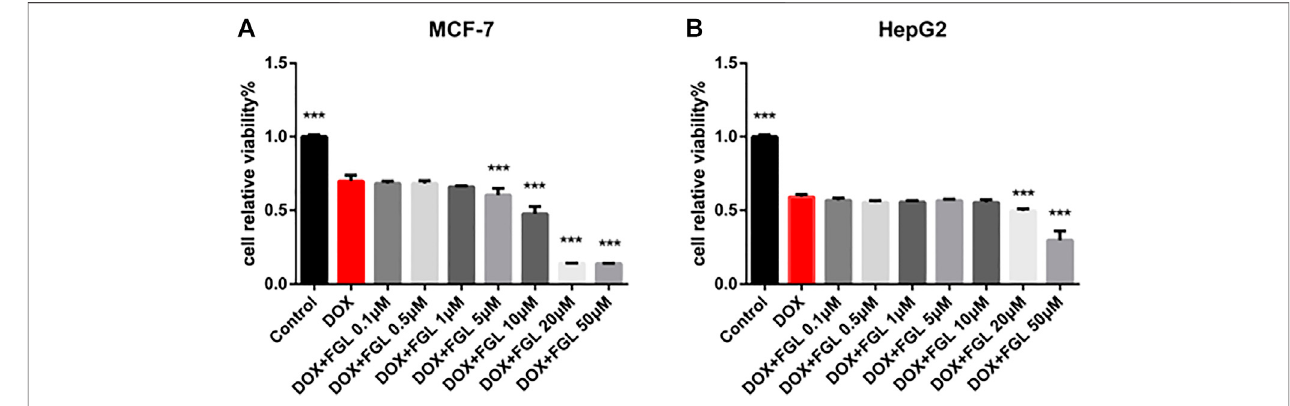
FIGURE 7 | FGL did not interfere with the antitumor effect of DOX. (A, B) The in fl uence of FGL on the anticancer effect of DOX on MCF-7 and HepG2 cells was determined by CCK-8 assay (n (cid:2) 6). *** p < 0.001 vs DOX group.